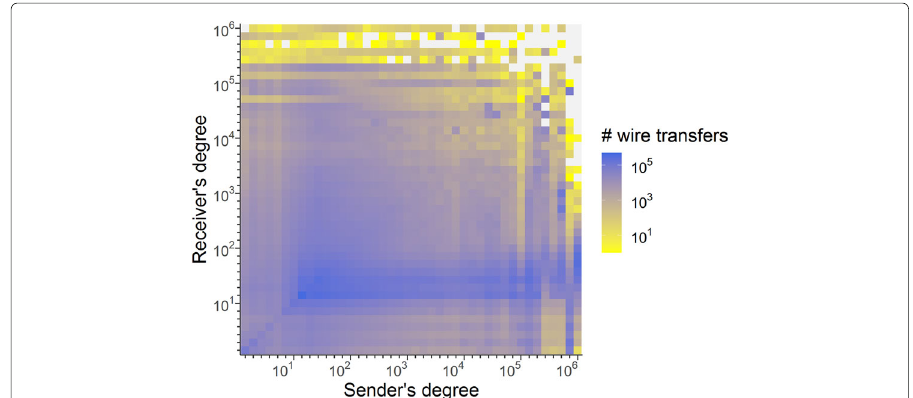
Fig. 10 General degree correlation heat map: The heat map plots, for each point ( d x ; d y ) , the number of directed links connecting nodes with degree d x to nodes with degree d y . Here we refer to the 2017 wire transfers